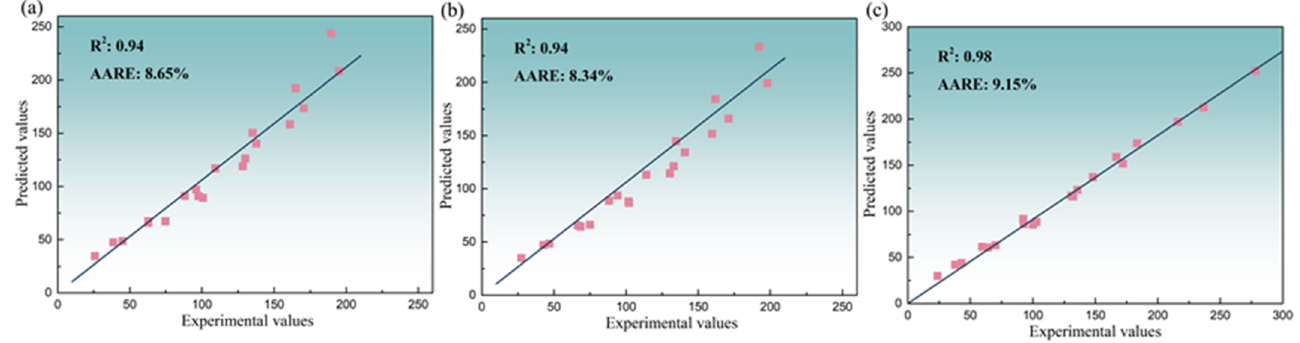
Figure 9. Comparison of the predicted and experimental flow stresses (strain − compensated constitutive equation) ( a ) AA5182, ( b ) AA5182 − 0.05Sc − 0.1Zr, and ( c ) AA5182 − 0.1Sc − 0.1Zr.